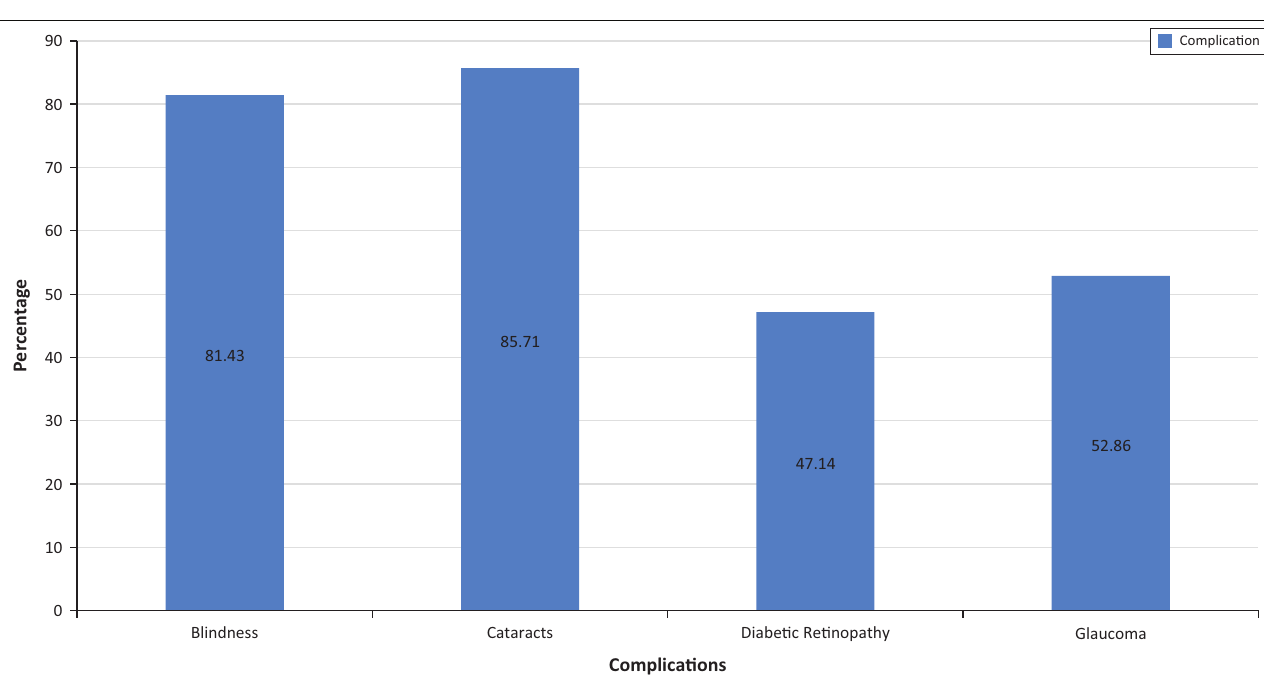
FIGURE 1: Awareness of ocular complications of diabetes mellitus amongst 70 diabetic patients at the National District Hospital in Bloemfontein, South Africa.